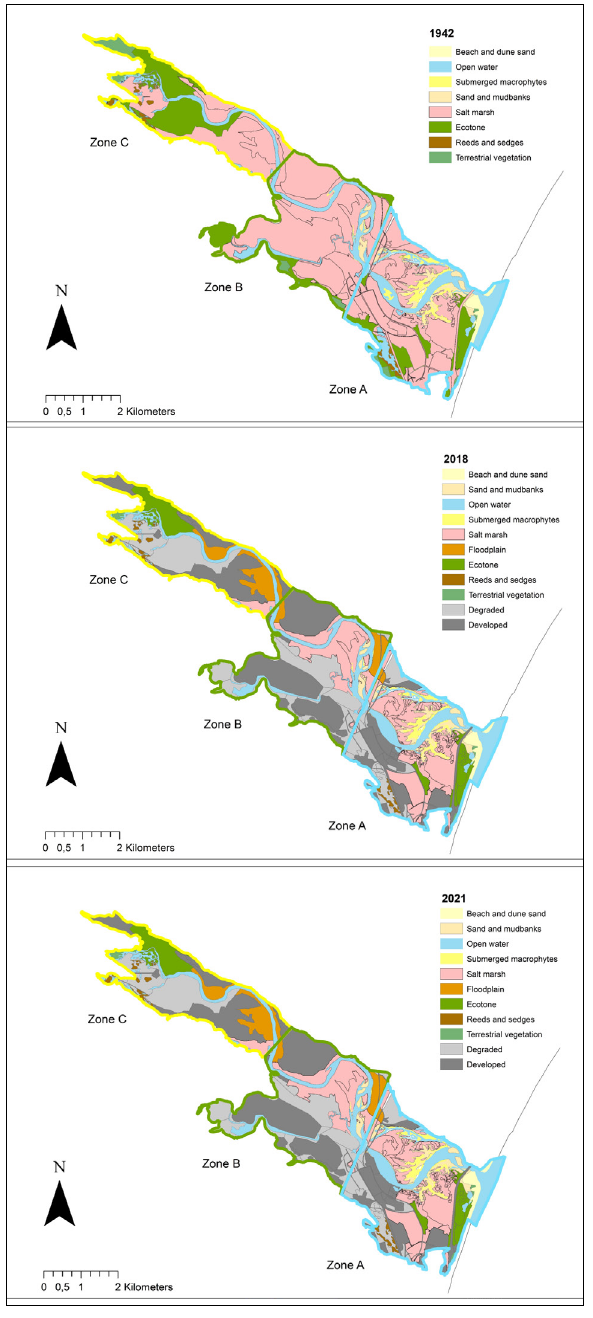
Figure 2: Geo-referenced maps depicting change in abiotic and biotic habitat extent in the Swartkops Estuary between 1942, 2018 and